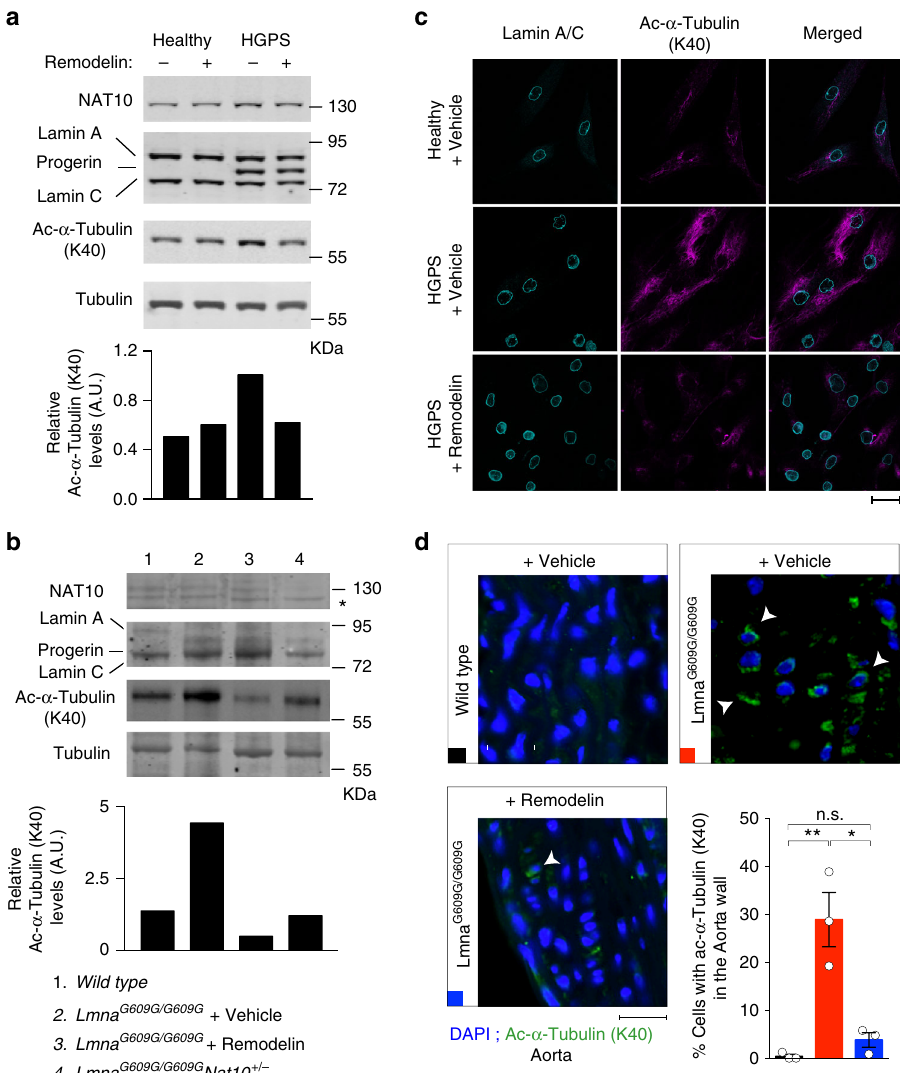
Fig. 5 Identi fi cation of potential readouts for Nat10 inhibition in cells and tissues. a , b Representative images of western blots showing that 1 µ M Remodelin treatment for 7 days decreases the high alpha-Tubulin ( α -tubulin) K40 acetylation in HGPS-patient derived cells ( a ) and mouse tissues ( b ). In panel b NAT10 chemical (lane 3) or genetic (lane 4) inhibition reverses the high α -tubulin K40 acetylation levels in heart tissues from indicated mice; *indicates a cross-reacting band. We note that the ratio between Lamin A and C appears to vary between tissues. All western blotting experiments were performed independently at least three times ( n ≥ 3/genotype). c Representative immuno fl uorescence images of acetyl- α -tubulin K40 in HGPS-patient derived cells, as compared to matching healthy fi broblasts. Scale bar = 20 µ m. The K40 α -tubulin acetylation (magenta) is increased in the HGPS-patient derived cells and decreased upon Remodelin treatment. d Representative immuno fl uorescence images (left) and quanti fi cation (right) of acetyl- α -tubulin K40 in aortas of terminal mice of the indicated genotypes and treatments. Scale bar = 10 µ m. The K40 α -tubulin acetylation (green; white arrowheads point to example of cells that show increased K40 acetylation) is increased in Lmna G609G/G609G mice and signi fi cantly decreased in such mice, upon Remodelin treatment ( n = 3; mean ± s.d.; individual data points represented; n.s. not signi fi cant, * p < 0.05; ** p < 0.01, *** p < 0.001; two-tailed Student ’ s t -test). For better visualization, these are higher magni fi cation snapshots (red dotted squares) from images in Supplementary Fig. 9d. Quanti fi cation was performed on full size aorta images from n = 3 independent